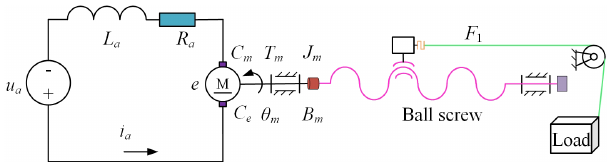
Figure 10. Mechanism of drive unit